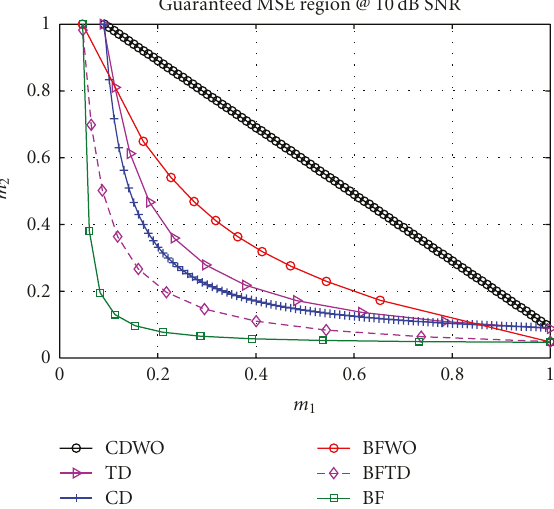
Figure 5: Guaranteed MSE region with and without superposition coding and with full collisions compared to perfect CSI and nonlinear and linear precoding with and without time-sharing for SNR